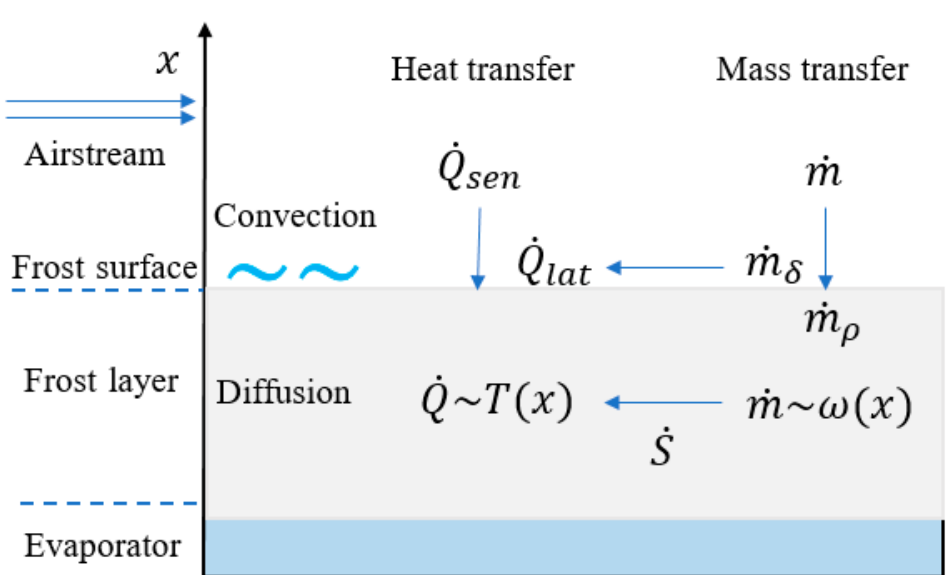
Figure 2. Schematic diagram of the frosting process during humid air flowing over the cold surface. In the airside, convective heat and mass transfer between the airstream and the frost layer is mainly considered. The differential equations are as following,